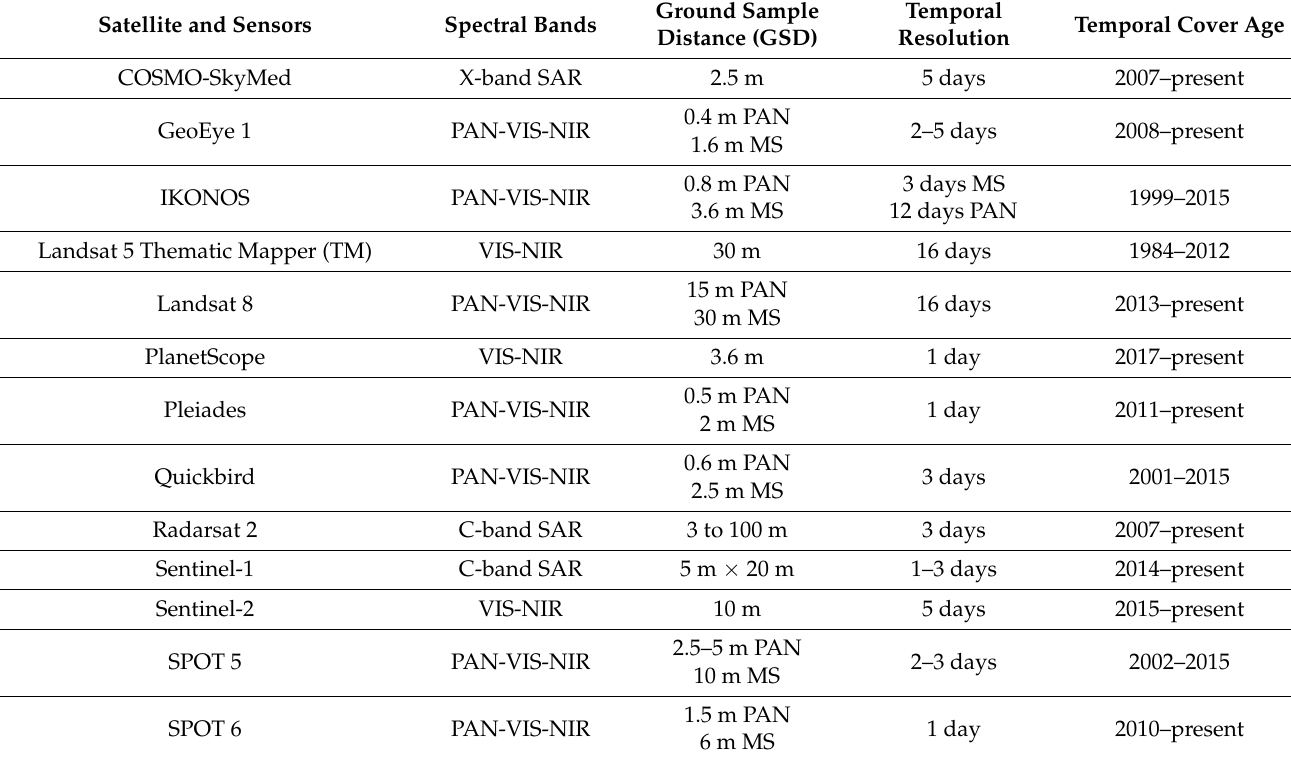
Table 2. The main characteristics of satellites used in olive growing